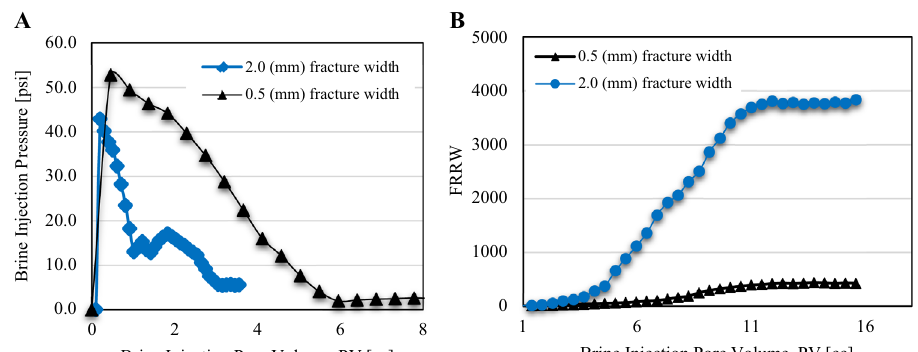
Fig. 13 a Brine injection in 0.5 mm and 2.0 mm frac- ture width using 1450 pa gel strength and b Frrw in 0.5 and 2.0 mm fracture width using 1450 pa gel strength